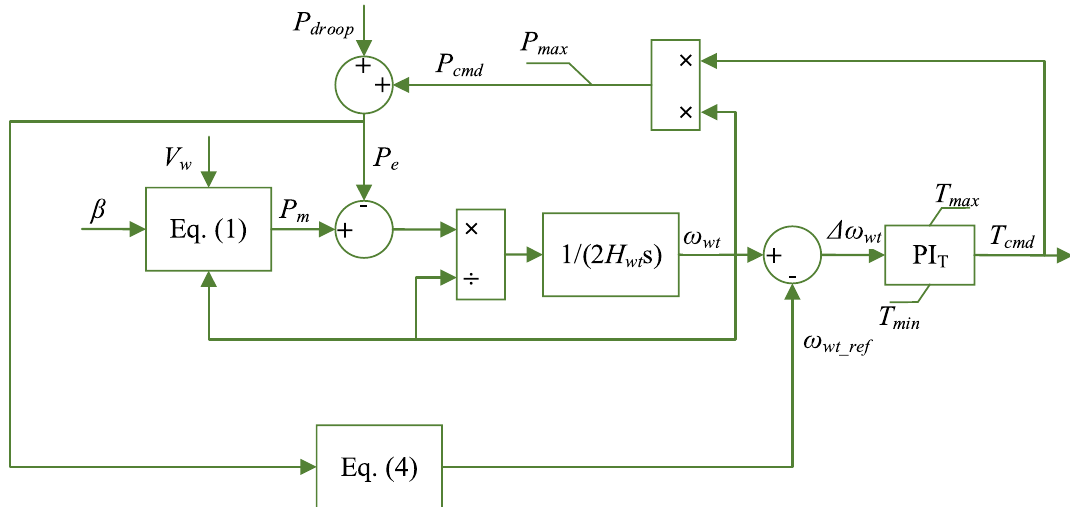
Fig. 2 Block diagram model of the proposed type 3 wind turbine